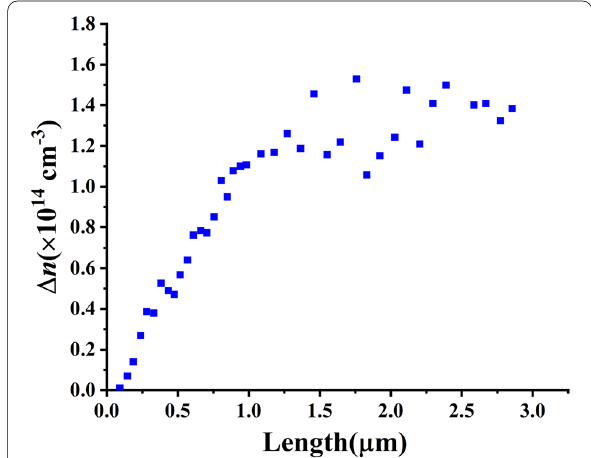
Fig. 2 The difference in electron density (cid:31) n between illumination and dark conditions from the experimental data in Ref.